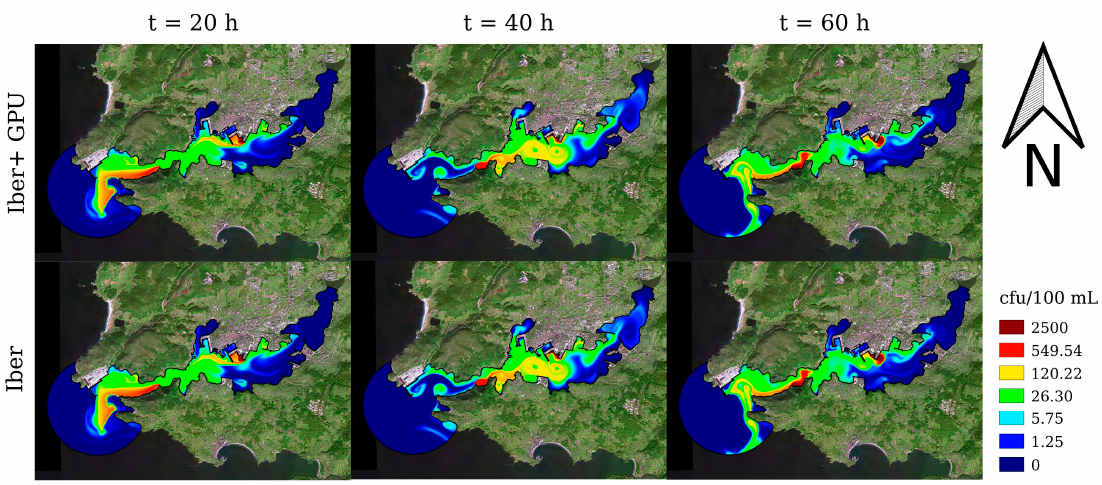
Figure 4. Comparison of Escherichia coli concentrations at different time steps obtained with Iber (CPU) and Iber+ (GPU).